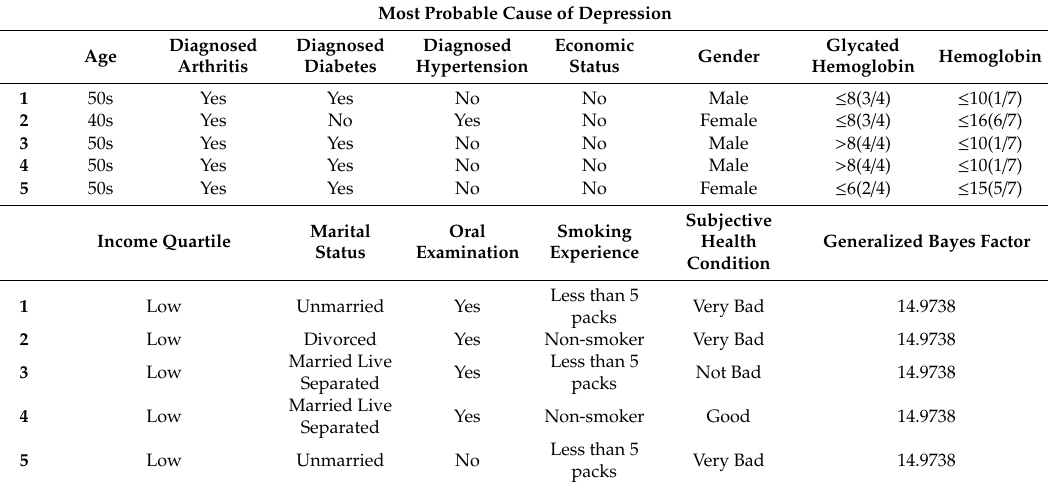
Table 3. Variables selected based on the genetically induced most probable cause of